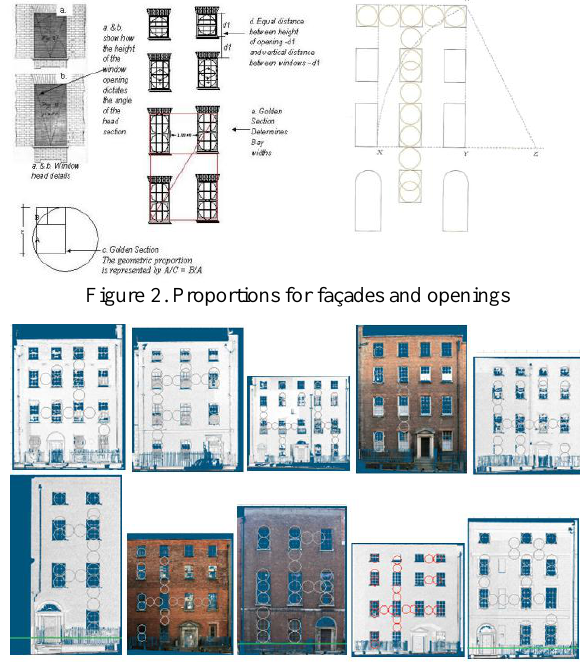
Figure 2. Proportions for façades and openings